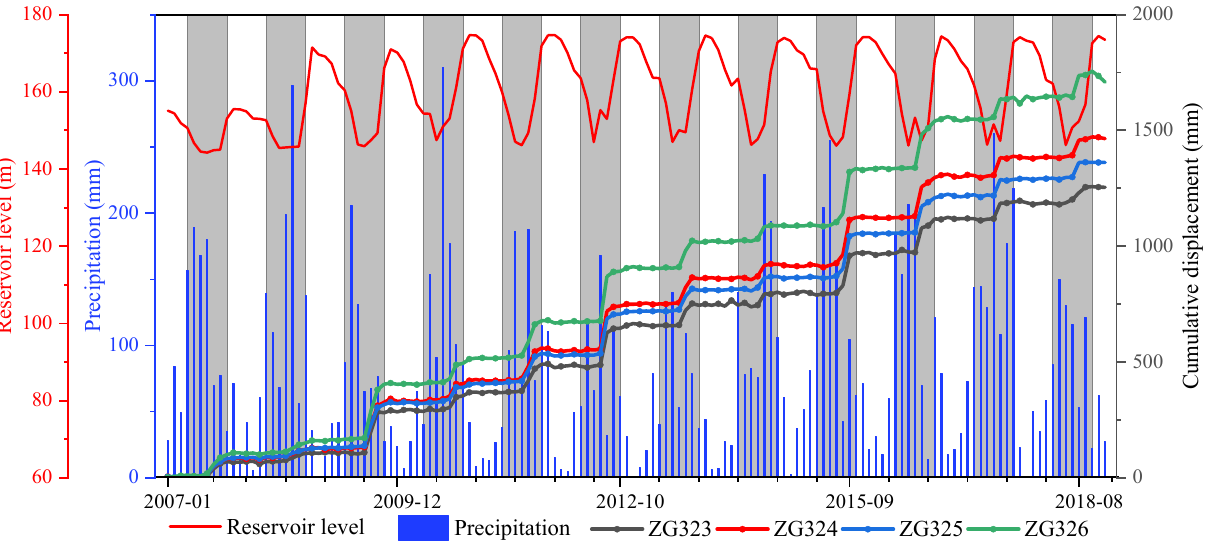
Figure 5. Precipitation, reservoir level, and measured cumulative displacement in the Baijiabao landslide: white fill—dry season; gray fill—rainy season.